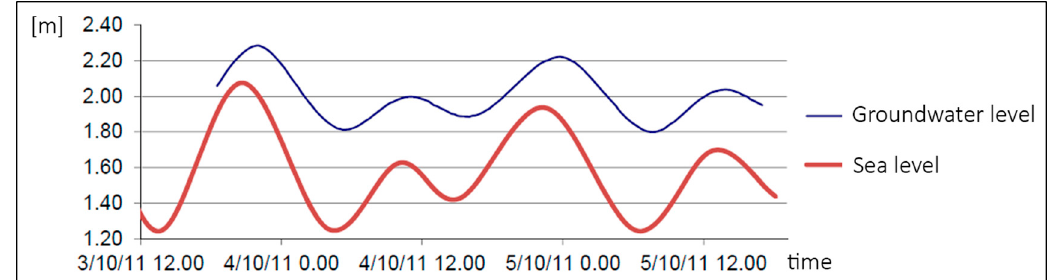
Figure 5. Sea and groundwater levels over a two-day observation period (compared to RL) in monitoring well S1 where the phreatic level varies within a range of 1.80–2.30 m every 6 h.